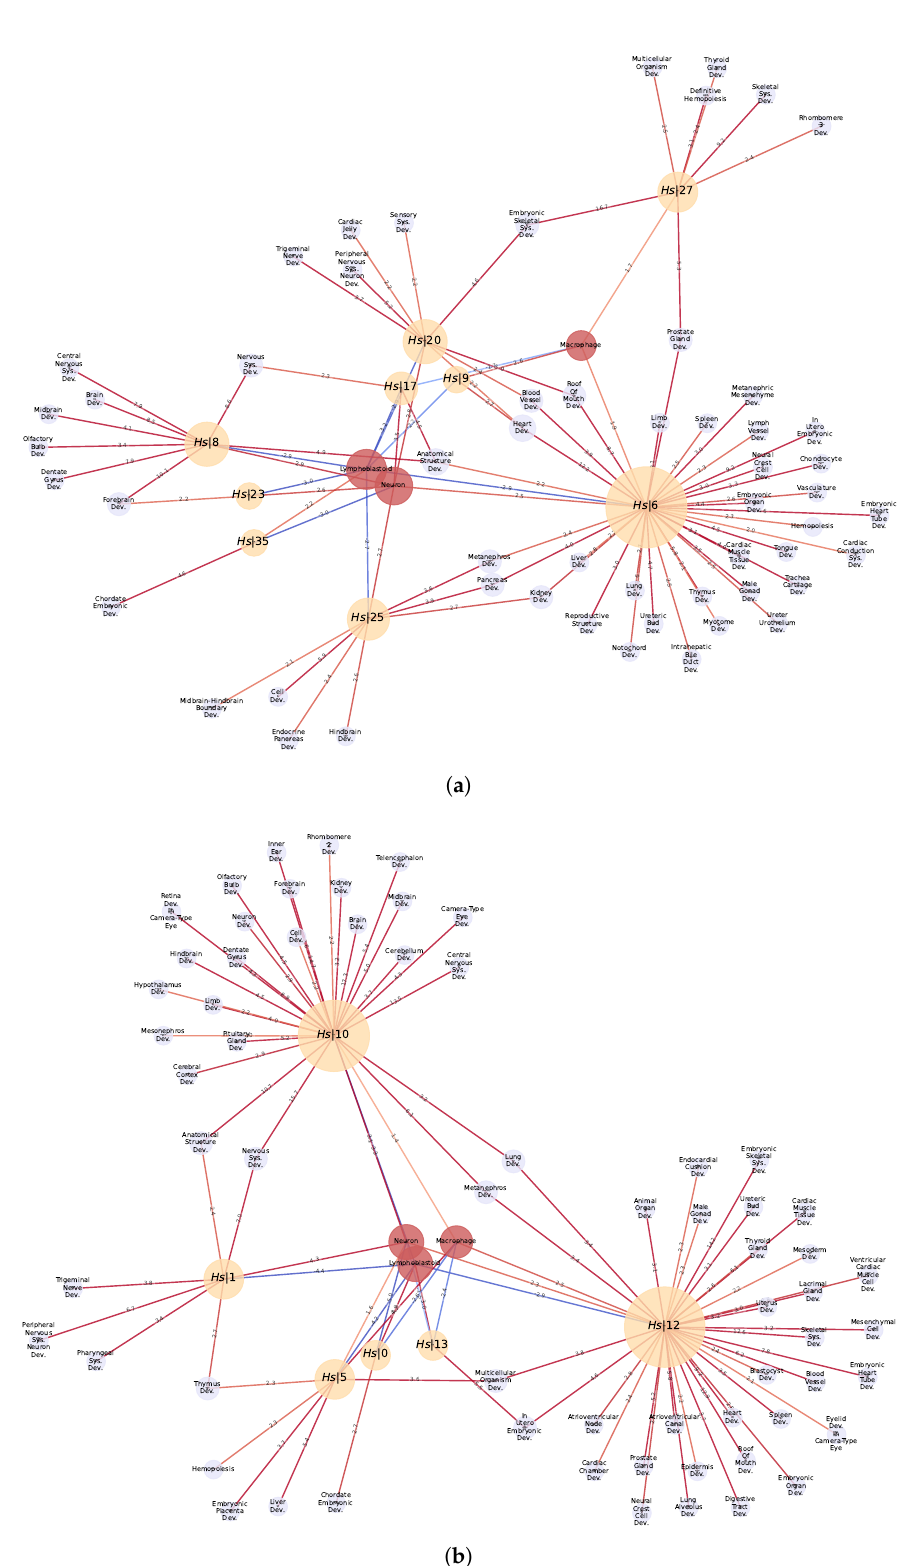
Figure 9. Statistically significant Normalized Enrichment GSEA Scores between cell-types (red nodes) and GXN•OMP and GXN•EN GRN communities (yellow nodes), and statistically significant associations between GO terms (blue nodes) and GXN•OMP and GXN•EN communities, for the H. sapiens dataset; ( a ) GXN•OMP- H. sapiens ; ( b ) GXN•EN- H. sapiens